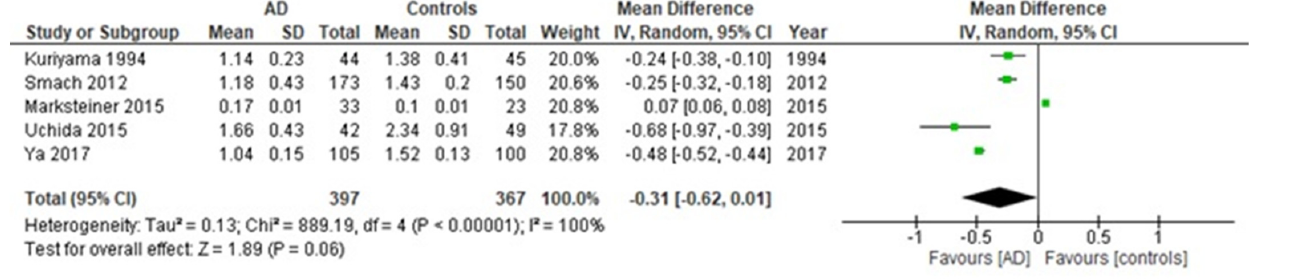
Figure 2. Forest plots for ApoA1 serum levels in AD and healthy controls .